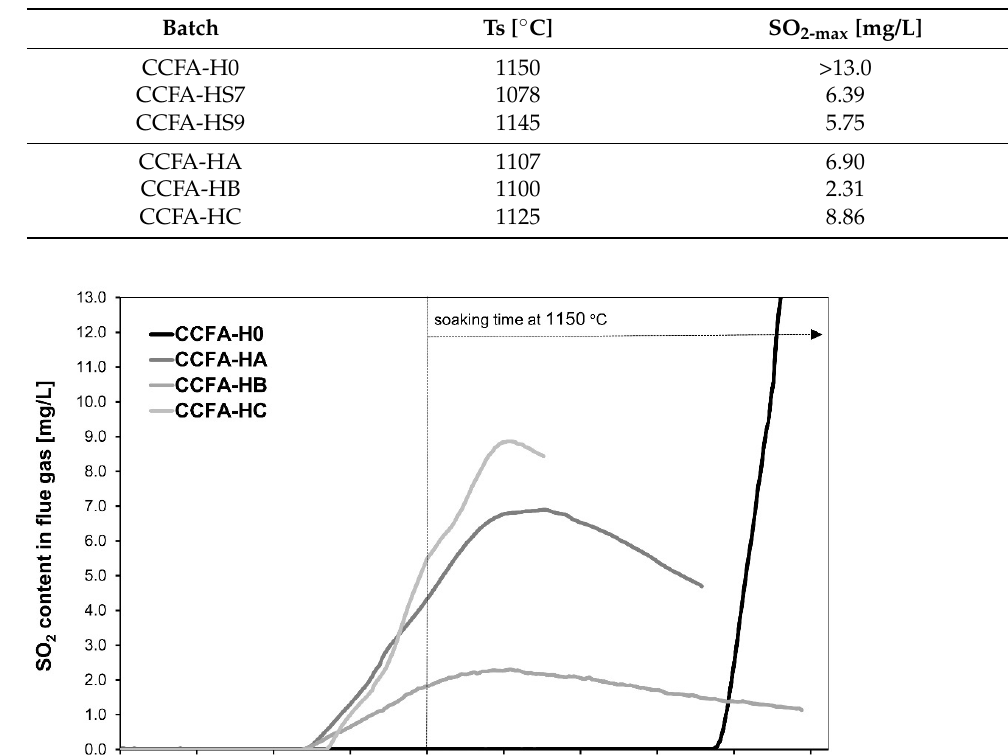
Figure 7. XRD patterns: The mineralogical composition of CCFA-H fired bodies depending on the different contents of sodium carbonate (W: Wollastonite, H: Haüyne, An: Anorthite, Q: Quartz, He: Hematite). Table 8. The temperatures of anhydrite decomposition start (Ts) and the maximum measured quantity of SO 2 in the flue gas during the firing (SO 2 -max).